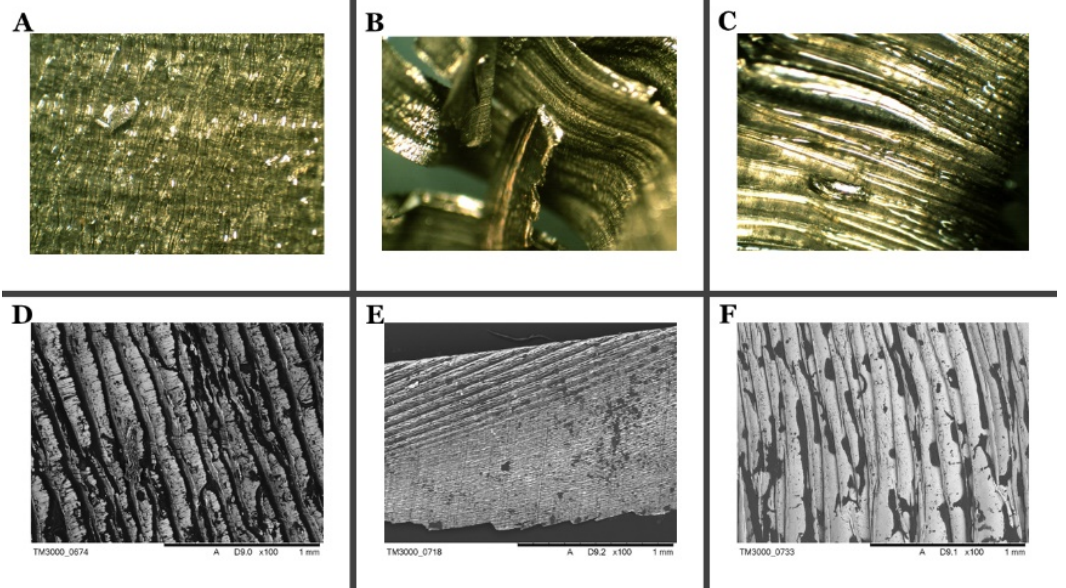
Figure 3. The surface of materials from SEM pictures: Titanium Grade 5; dark side, magnification 40× ( A ), Titanium Grade 5; dark side, magnification up to 1 mm ( D ), Inconel 625; dark side, magnification 40× ( B ), Inconel 625; dark side, magnification up to 1 mm ( E ), Inconel 718; dark side, magnification 40× ( C ), Inconel 625; dark side, magnification up to 1 mm ( F ).